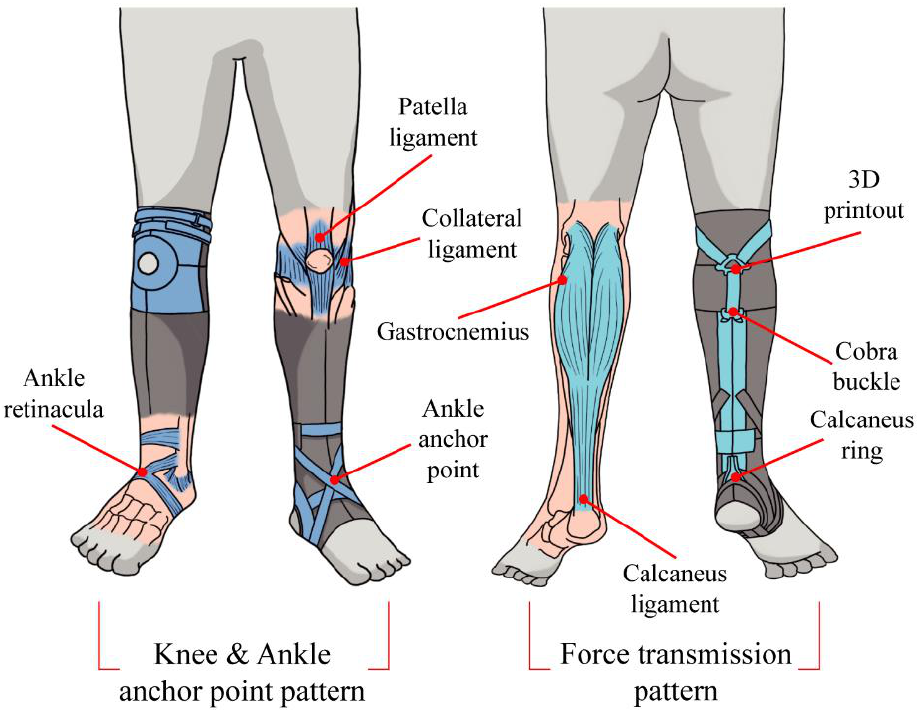
Figure 4. Anchor point pattern and force transmission pattern designed bio-inspired by the muscles, ligaments, and retinacula play a role in supporting and transmitting the force of the kneE-XOcks. The force transmission pattern mimics the function and shape of gastrocnemius and performs plantar flexion at the ankle joint. At this time, knee anchor point and ankle anchor point prevent the kneE- XOcks from being taken off and play a role in transmitting the force to each correct position. The knee anchor point mimics the function and shape of the ligaments around the patella, and the ankle anchor point simulates the function and shape of the ankle